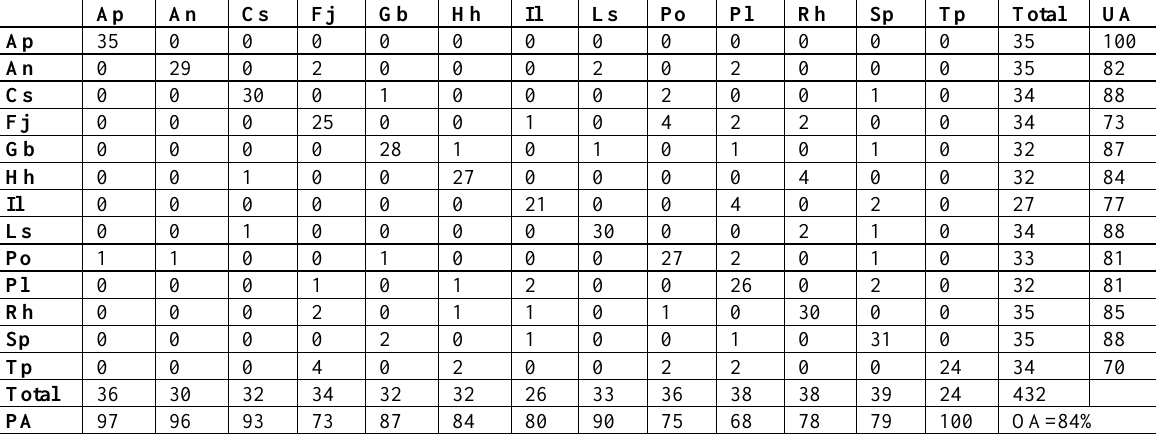
Table 3: Confusion Matrix of Support Vector Machine used Poly Kernel Classifier (SVM-Poly